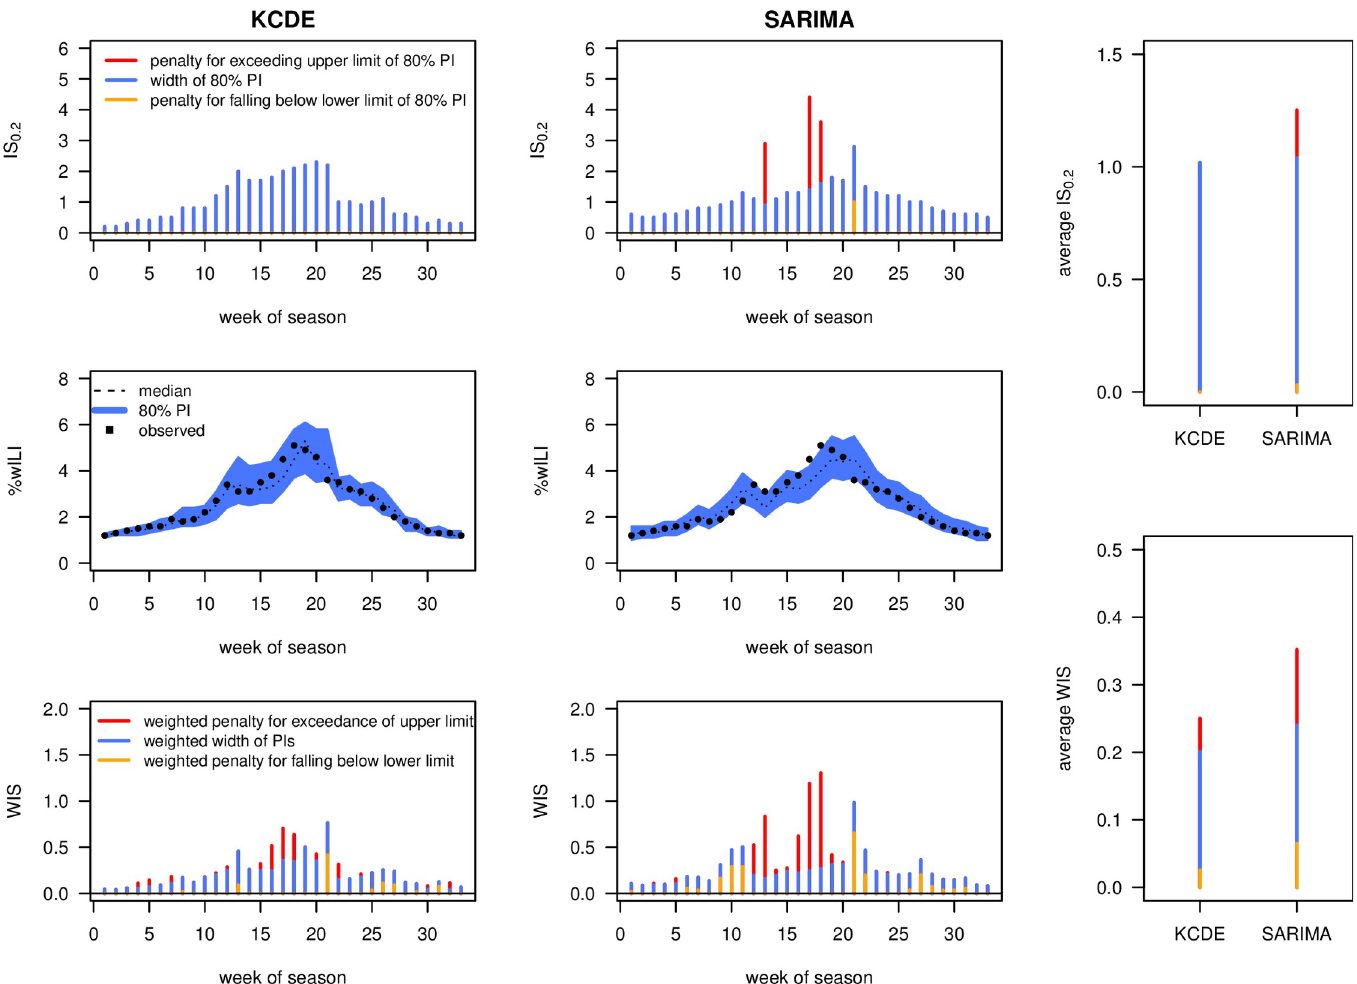
Fig 4. Interval and weighted interval score applied to FluSight forecasts. Comparison of 1-week-ahead forecasts by KCDE and SARIMA over the course of the 2016/ 2017 FluSight season. The top row shows the interval score with α = 0.2 , the bottom row the weighted interval score with α 1 = 0.02, α 2 = 0.05, α 3 = 0.1, ... , α 11 = 0.9 . The panels at the right show mean scores over the course of the season. All bars are decomposed into the contribution of interval widths (i.e., a measure of sharpness; blue) and penalties for over- and underprediction (orange and red, respectively). Note that the absolute values of the 2 scores are not directly comparable as the WIS involves rescaling of the included interval